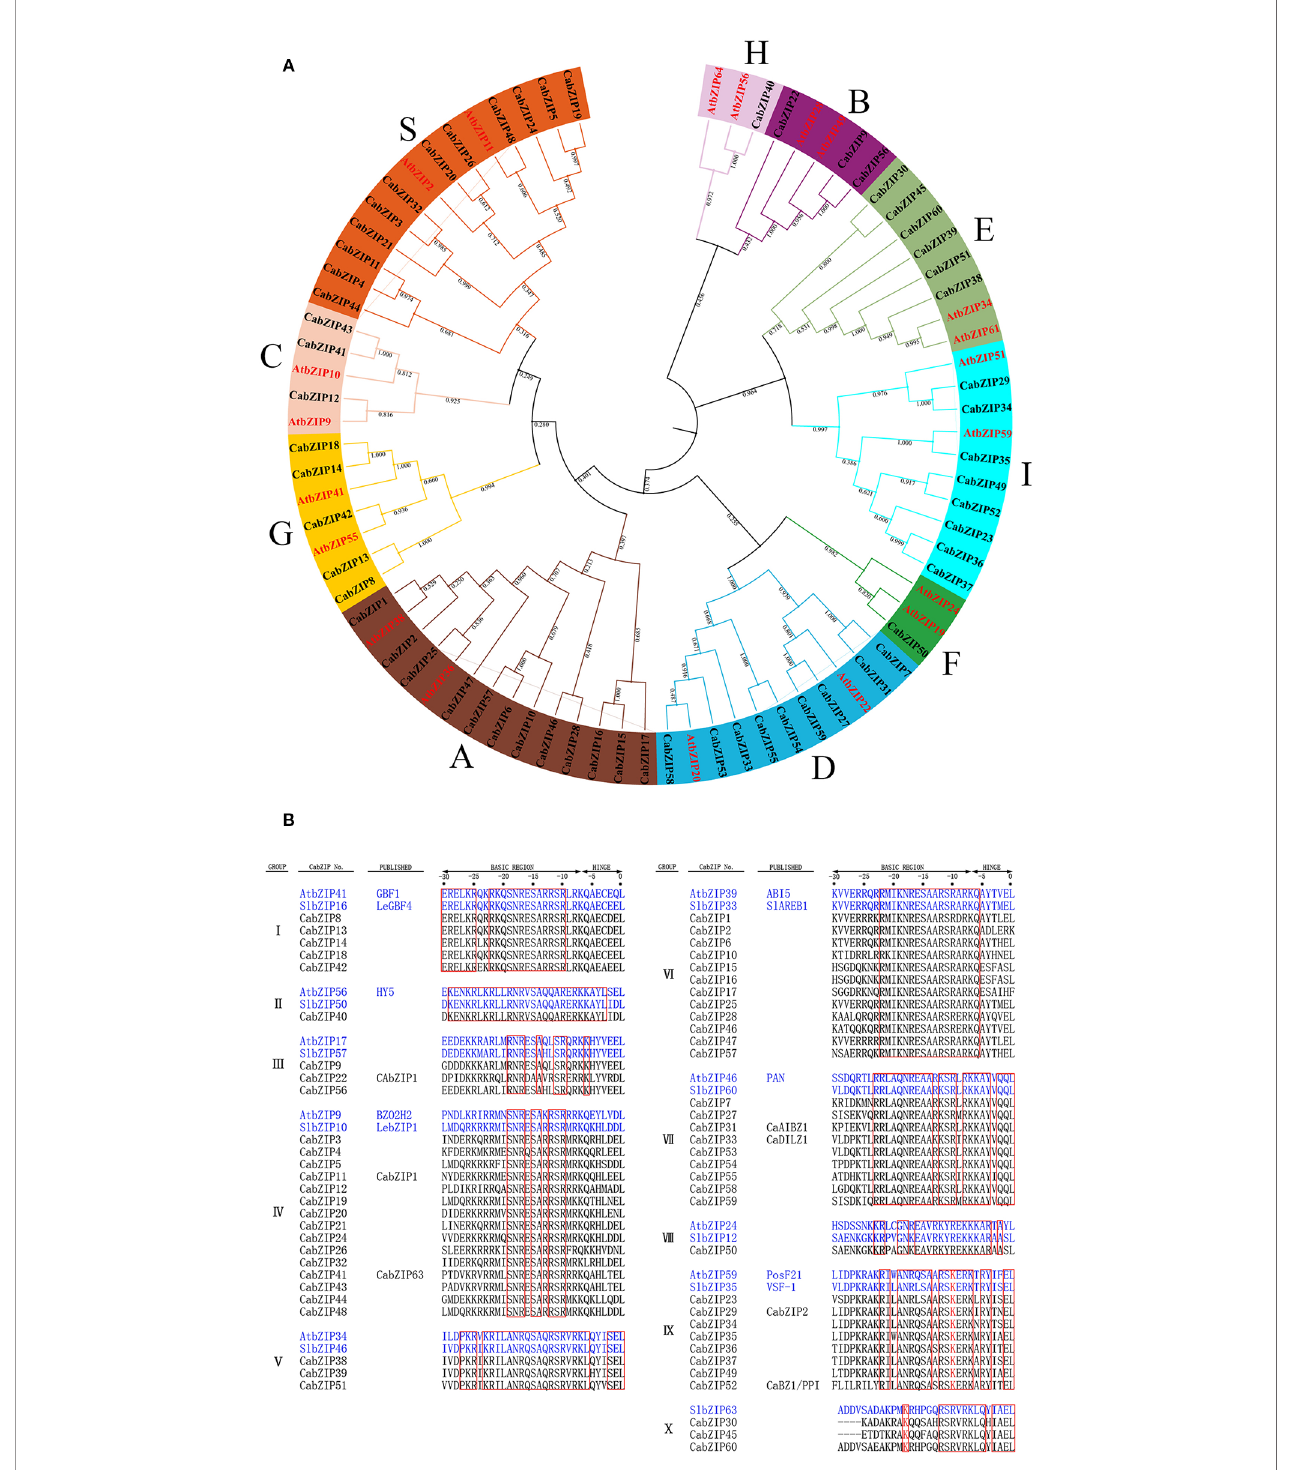
FIGURE 1 | Phylogenetic relationship of pepper and Arabidopsis bZIP proteins and alignment of basic and hinge regions of the CabZIP proteins. (A) The protein sequences of the bZIPs, 60 from pepper (CabZIPs) and 20 from Arabidopsis (AtbZIPs, red color), were aligned by MUSCLE at MEGA-X and the phylogenetic tree was constructed by NJ method. The proteins were clustered into 10 groups, which were assigned a different color. (B) Alignment of basic and hinge regions of 60 CabZIP proteins. The CabZIP proteins are classi fi ed into 10 groups. Conserved amino acids are boxed in red. Two already characterized plant bZIP proteins in Arabidopsis and tomato are shown as references. The fi rst Leu of the Leu zipper is regarded as 0. The different amino acid residue K belonging to group X are colored at -18